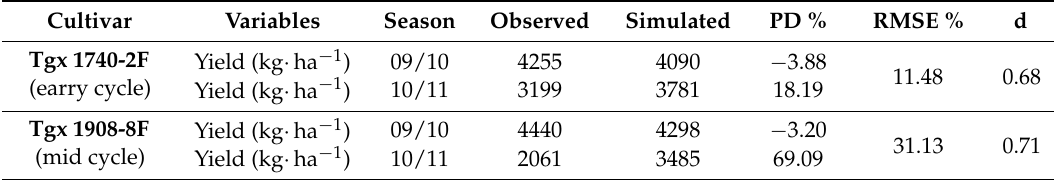
Table 4. Average values of observed and simulated yields by the CROPGRO-Soybean model for Tgx 1740-2F and Tgx 1908-8F soybean cultivars for the 2009/2010 and 2010/2011 seasons in Angónia, Tete Province, Mozambique.